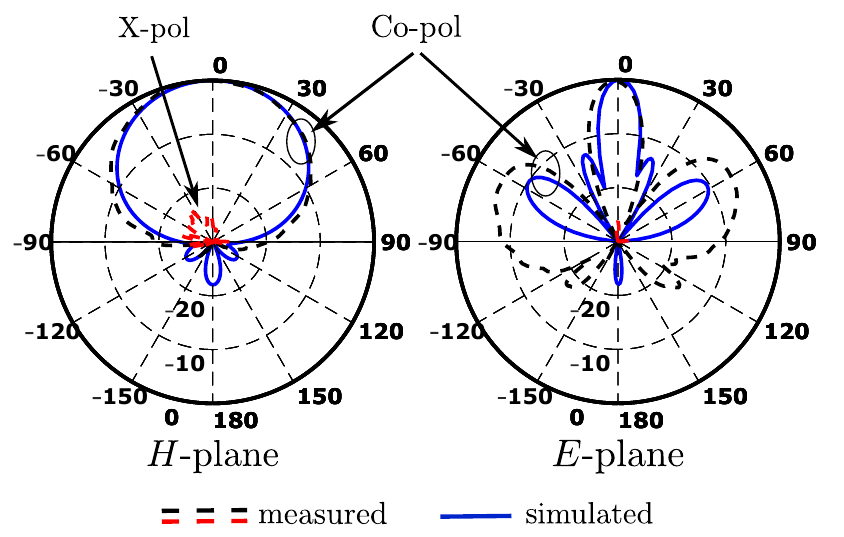
Figure 13. Simulated and measured radiation patterns of four-element standing-wave DRA